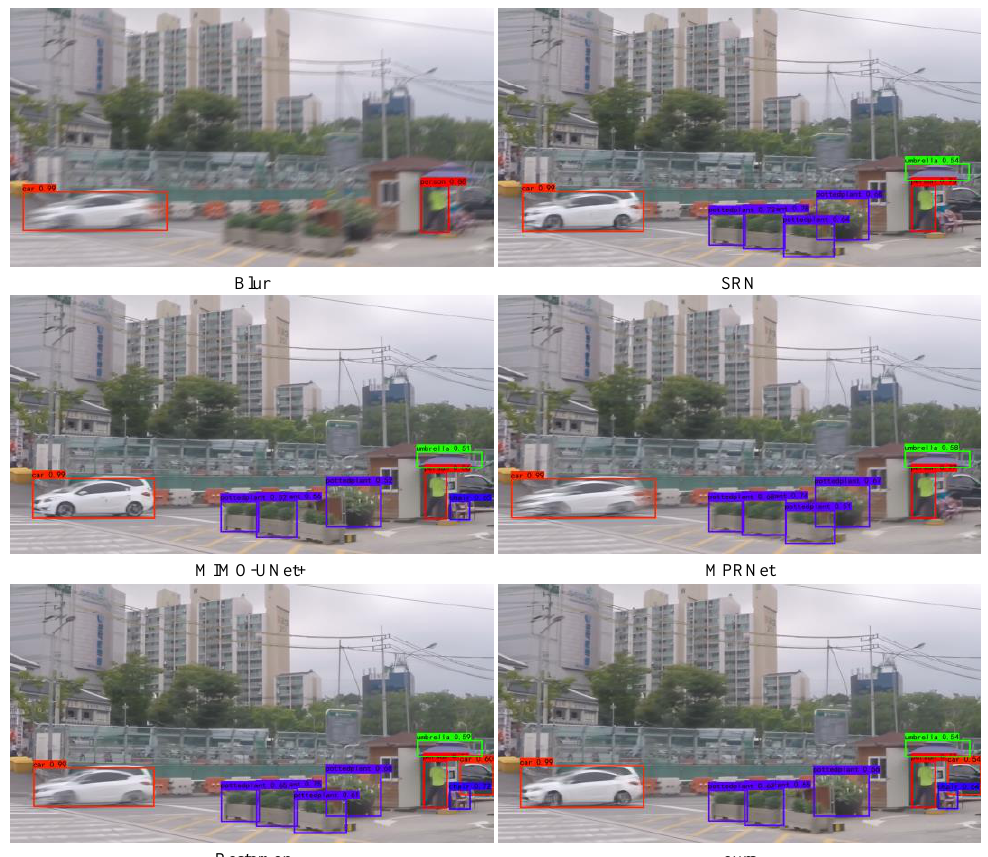
Figure 9. The visual example of object detection. From top left to bottom right: blurry images, the restoration of SRN [12], MPRNet [2], MIMO-Unet+ [8], Restomer [18], and our model. Table 4. The detection evaluation result of each object. “ ☓ ” means this object cannot be detected in the restoration of the current deblurring model.